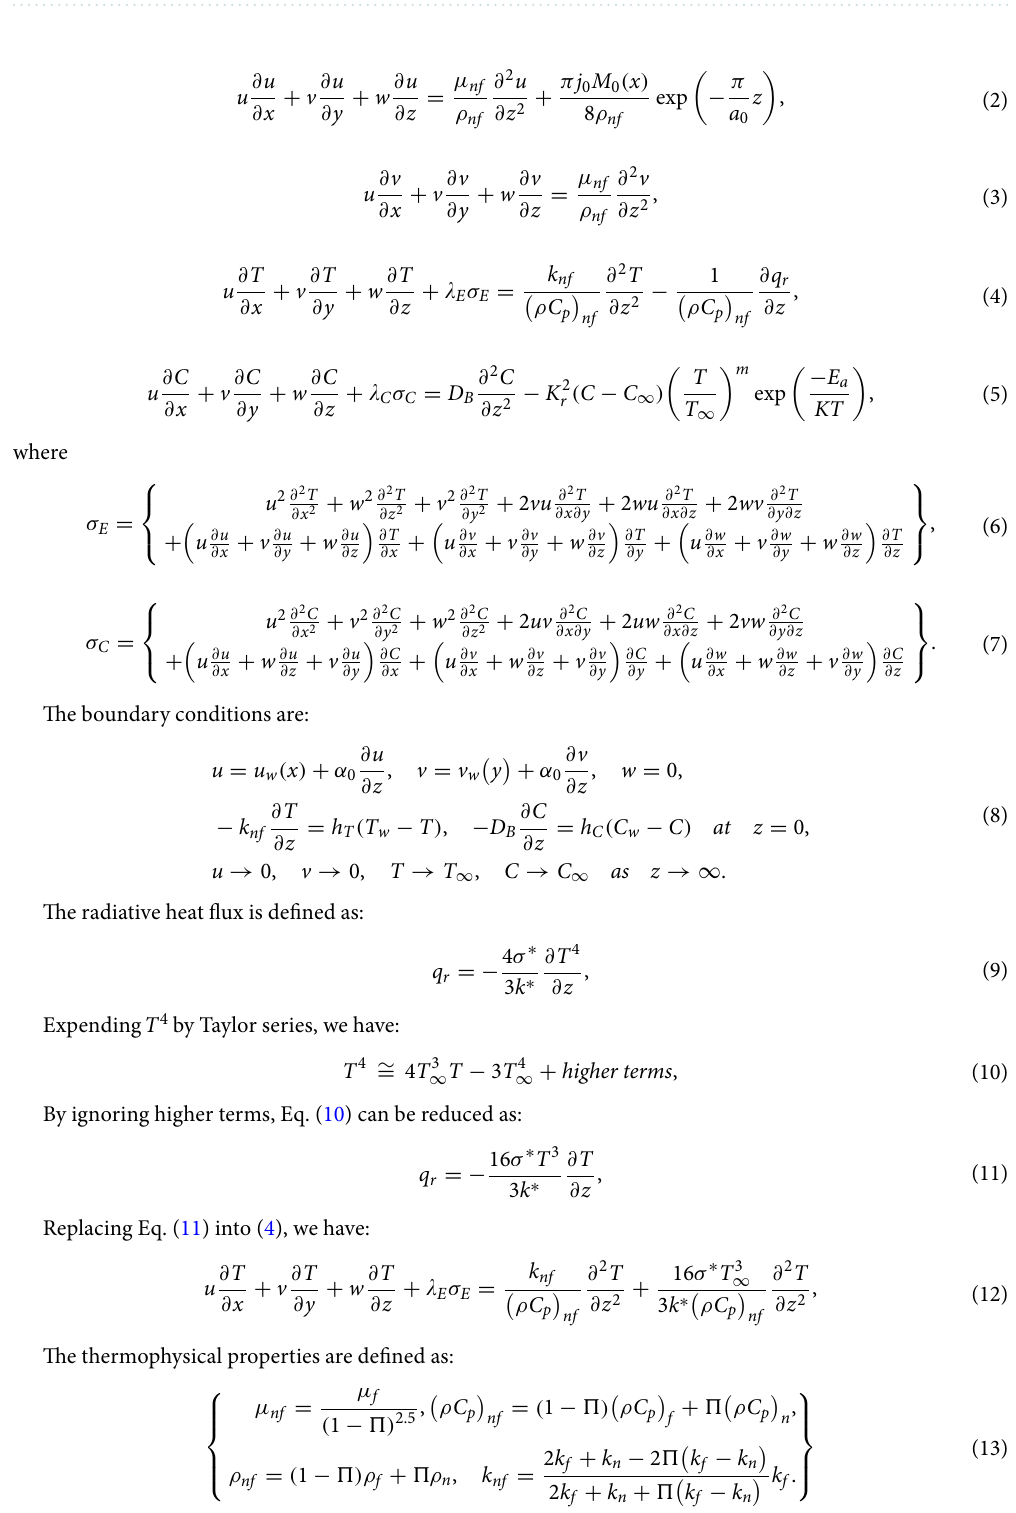
Table 1. Numerical values of thermophysical properties of H 2 O and ZnO 42–45 .